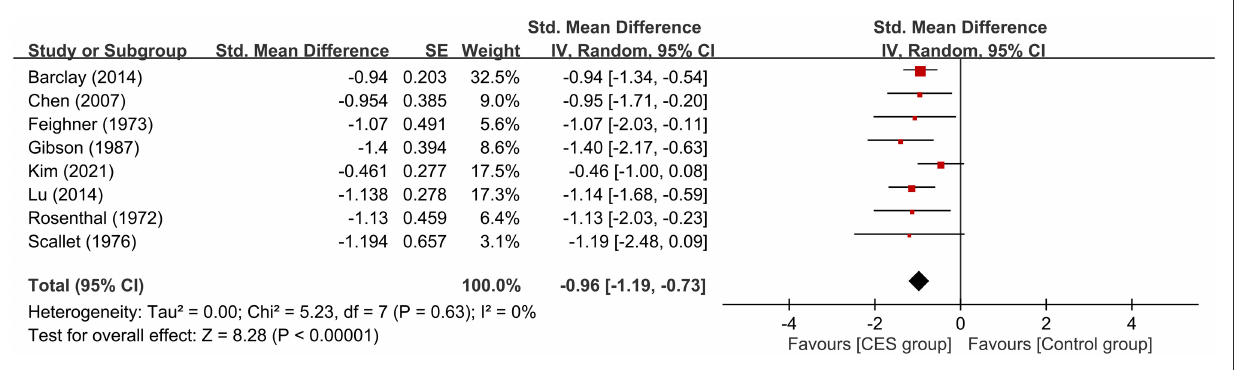
FIGURE3 Forest plot comparing the severity of anxiety symptoms between CES and control groups. CES, cranial electrotherapy stimulation; Std, standardized; CI, confidence interval; SE, standard error.